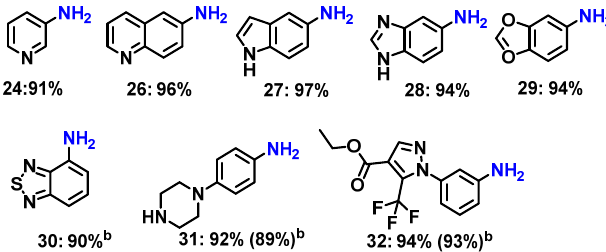
Figure 6. Recycling of Fe 9 TiO 15 @TiO 2 catalysts for the reduction of nitrobenzene to aniline. Reaction conditions: 5-mmol nitrobenzene, hydrazine hydrate, 50 mg catalyst (4 mol% Fe), 20 mL THF, 15 h, 100 °C, yields were determined by GC using n-hexadecane as standard. 3. Experimental Section 3.1. Materials and Methods Ferrocene, titanium isopropoxide, triflic acid (TFC) and tetrahydrofuran (THF), nitro compounds and anilines were obtained from Sigma-Aldrich (Shanghai, China) and used without any purification. The XRD patterns were recorded using a Smart Lab X-ray diffractometer (Rigaku, Akishima-shi, Tokyo, Japan) using Cu-K α X-rays radiations ( λ = 0.15406 nm). X-ray photoelectron spectroscopy (XPS) was carried out with ESCALAB 250Xi, Thermo Scientific Waltham, MA USA instrument. The adventitious carbon peak appeared at binding energy of 284.8 eV was used as a reference. The surface morphology (SEM) and energy dispersive X-ray (EDS), analysis were carried out by field emission scanning electron microscope (FESEM-Tescan Lyra-3, (Kohoutovice, Czech Republic ) equipped with focused ion beam (FIB) and EDS, detector. TEM analysis were performed using scanning transmission electron microscope (FEI Tecnai F-20, Graz , Austria ) coupled with a Fischione HAADF detector. Electron paramagnetic resonance (EPR) spectra were recorded in X-band at 273 K on an Adani SPINSCAN X-band electron paramagnetic resonance (Minsk, Belarus) spectrometer equipped with 020 4060 80100 0 Run